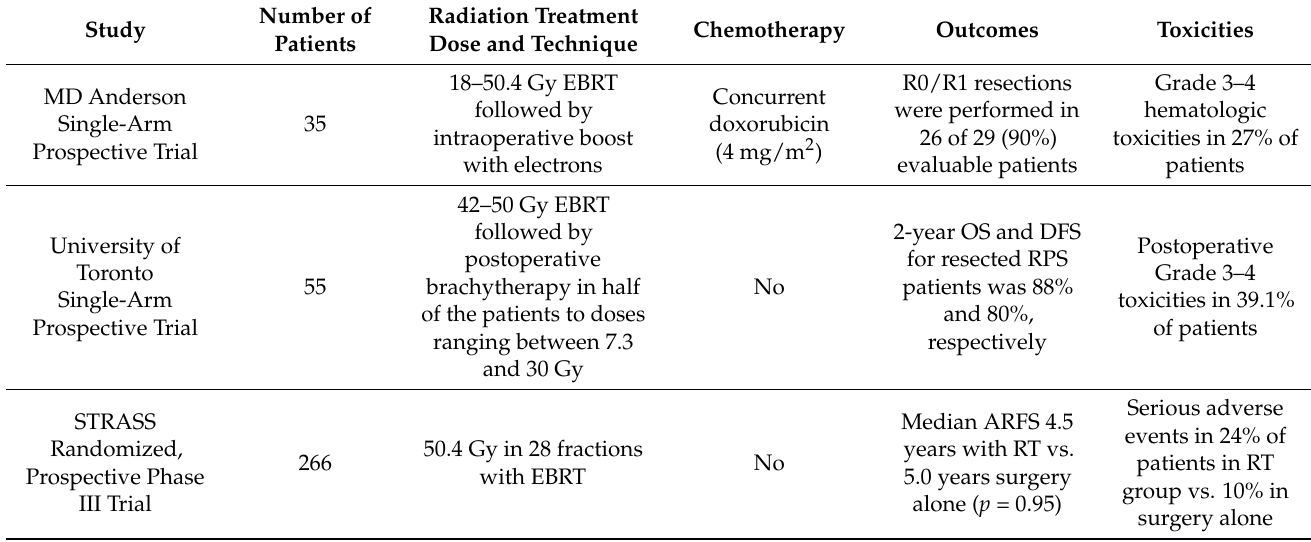
Table 1. Prospective studies evaluating the role of preoperative radiation therapy in the management of